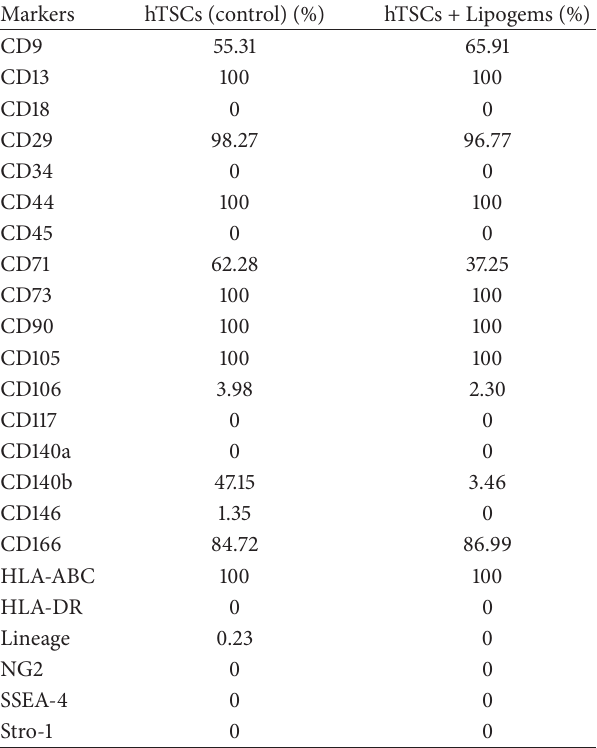
Table 1: Summary of the surface markers by cytofluorimetry of Lipogems-treated and control hTSCs. Numbers show the expression percentage for each cell surface